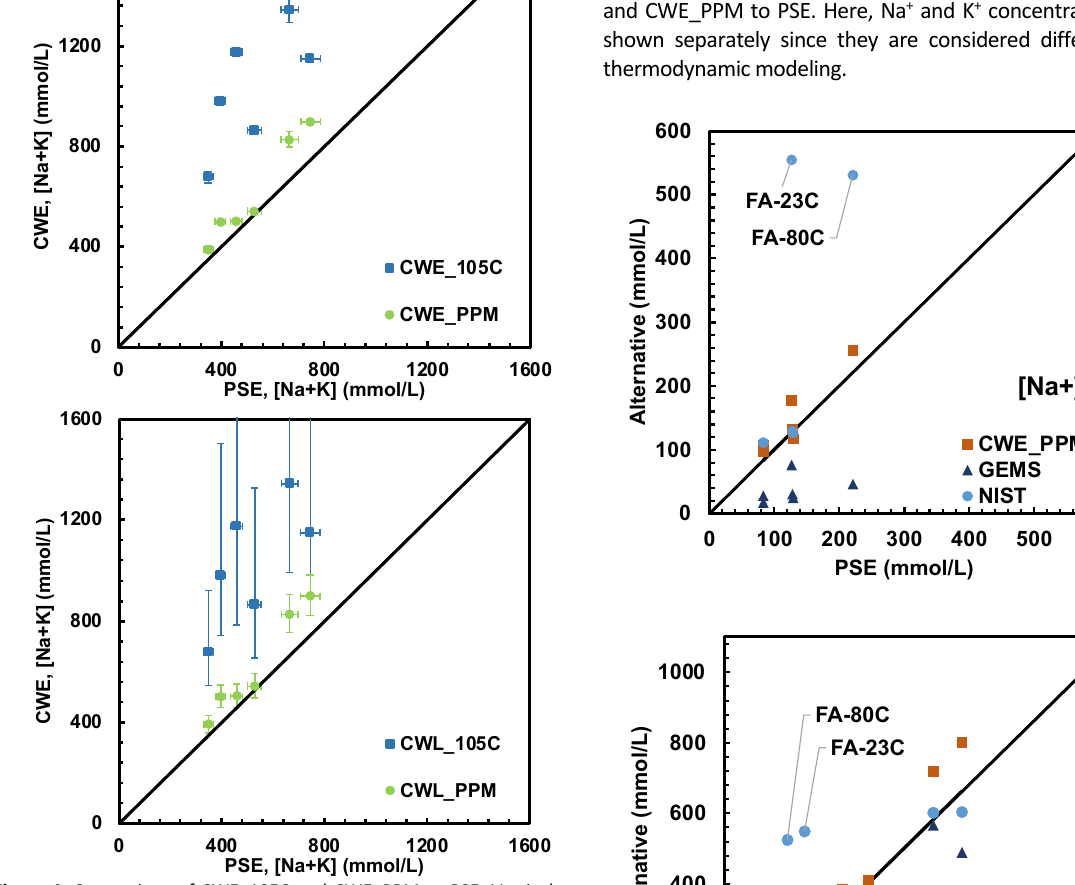
Figure 4. Comparison of CWE_105C and CWE_PPM to PSE. Vertical error bars either represent plus or minus one standard deviation between CWE repeat trials (top) or the hypothetical effect of increasing or decreasing %m w, evap. by 5% in the CWE adjustment (bottom). For horizontal error bars assigned to PSE, 5% error was assumed based on the data presented in [15].